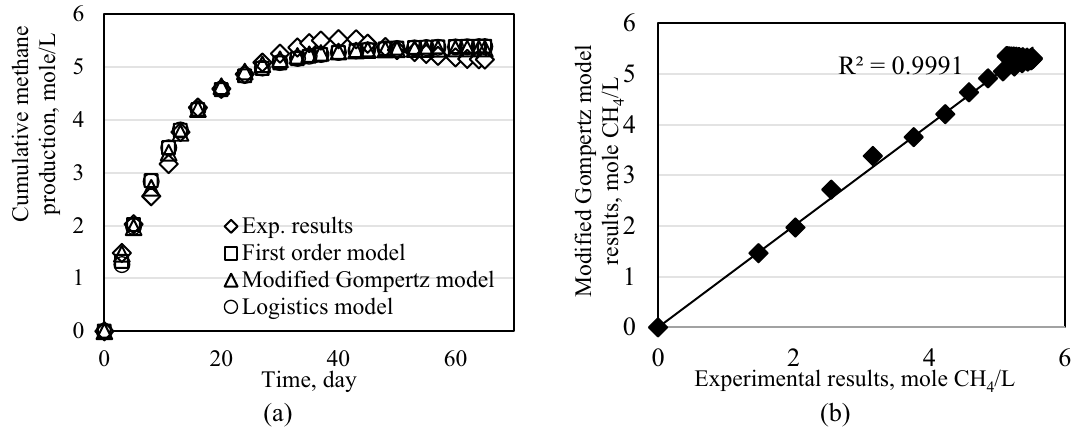
Figure 8. Results of models for Exp1. ( a ) Cumulative methane production for all models. ( b ) Modified Gompertz model results.